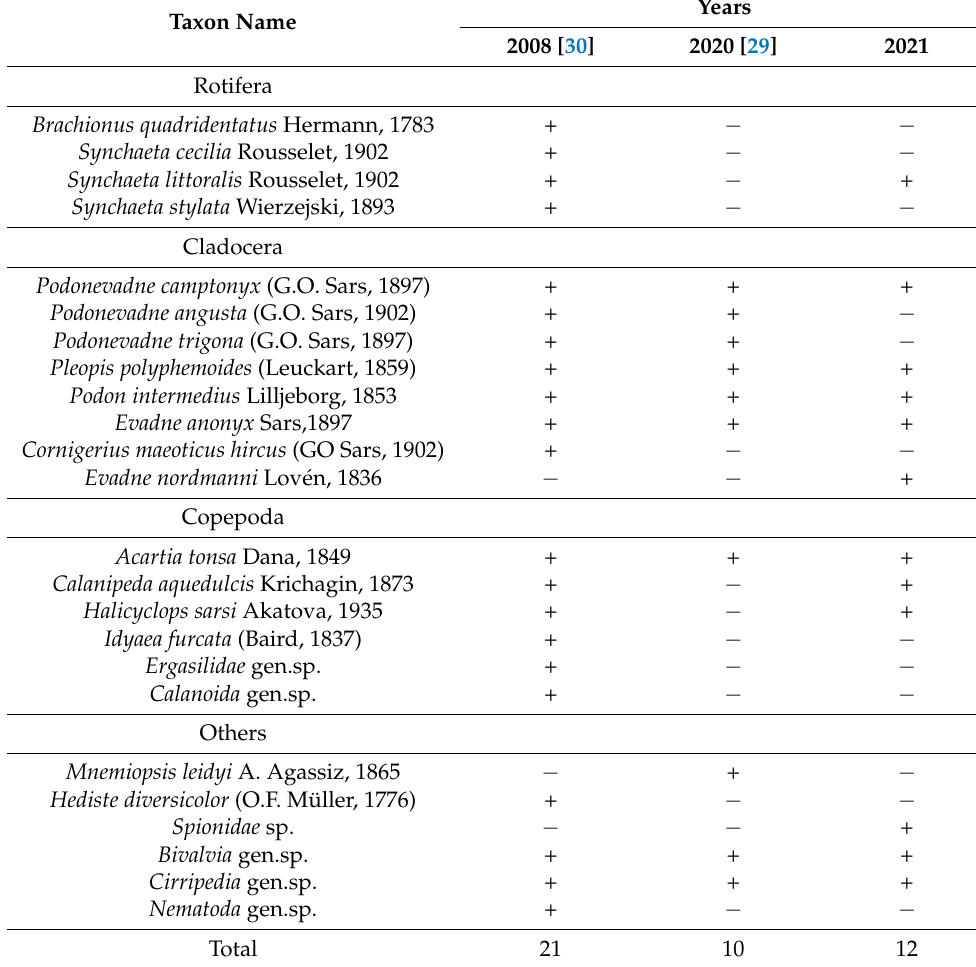
Table 3. The taxonomic changes in zooplankton communities of the Middle Caspian